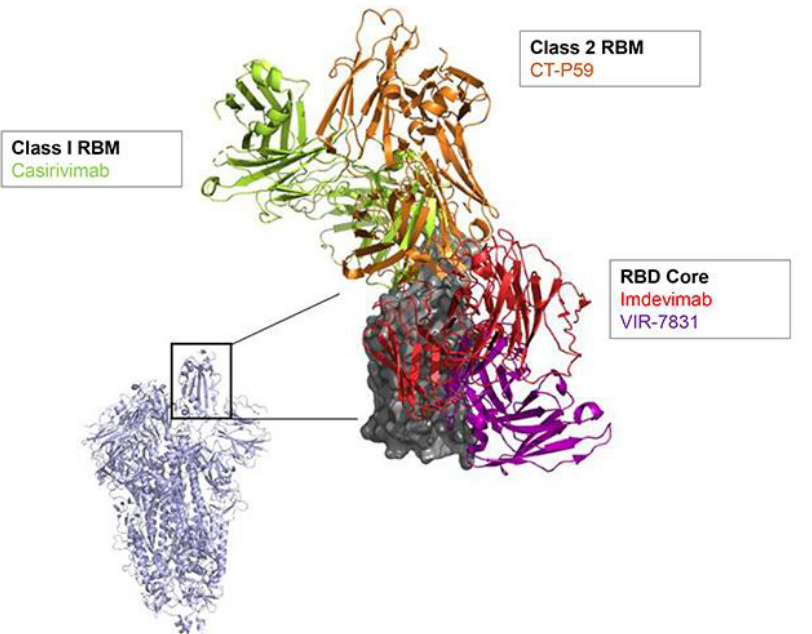
Figure 1. Localization of SARS-CoV-2 nAbs in late-stage clinical development. The distribution of RBD regions recognized by casirivimab (PDB: 6XDG), CT-P59 (PDB: 7CM4), imdevimab (PDB: 6XDG) and VIR-7831 (S309) (PDB: 6WPS) are compiled and illustrated on the SARS-CoV-2 virus (PDB:6W41). Epitopes are clustered proximal to RBM bound by ACE2, or alternatively at the distal RBD core. SARS-CoV-2 RBD is depicted in gray; the inset shows its location in the context of the entire spike protein (depicted in lavender). Only those nAbs with publicly available structures are shown. RBD, receptor binding domain; RBM, receptor binding motif.